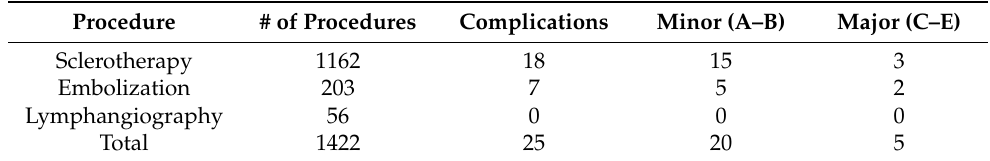
Table 3. Procedure-related complications per